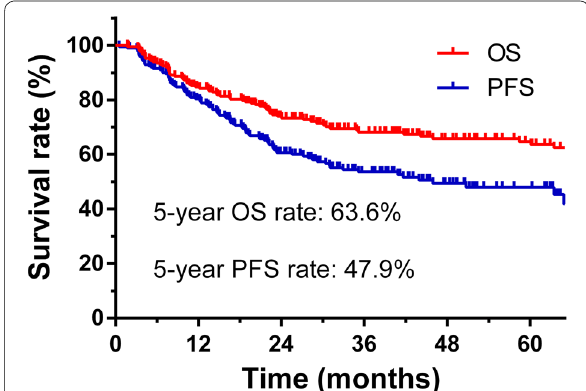
Fig. 1 Overall survival (OS) and progression‑free survival (PFS) of 215 patients with early‑stage nasal‑type extranodal natural killer/T‑cell lymphoma (ENKTCL)